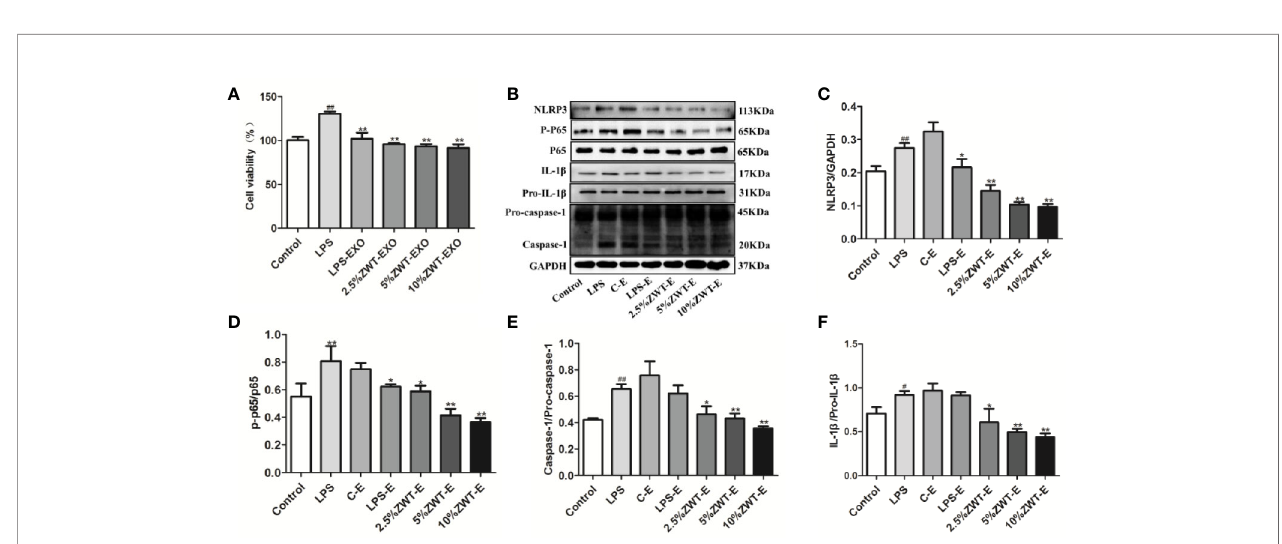
FIGURE 4 | Zhen-wu-tang (ZWT) regulated secretion of exosomes, which affected NF- k B/NLRP3 signaling pathway in the human mesangial cell (HMC) proliferation model. HMC were treated with lipopolysaccharide (LPS) (20 m g/ml) and cultured in the absence/presence of ZWT-EXO for 24 h. (A) Cell proliferation of HMC by MTT analysis. (n = 6). (B) Western blot was carried out to measure the expressions of NLRP3, p-p65, p65, caspase-1, pro – caspase-1, IL-1 b , and pro – IL-1 b in the HMC. (C – F) The statistical data of all the proteins were analyzed and transformed by ImageJ 1.8.0 112 software. The obtained values of p-p65 were normalized to p65, caspase-1 were normalized to pro – caspase-1 and IL-1 b were normalized to pro – IL-1 b . (n = 3). All values were presented as mean ± SD. # P < 0.05, ## P < 0.01, compared with control group; *P < 0.05, **P < 0.01, compared with LPS